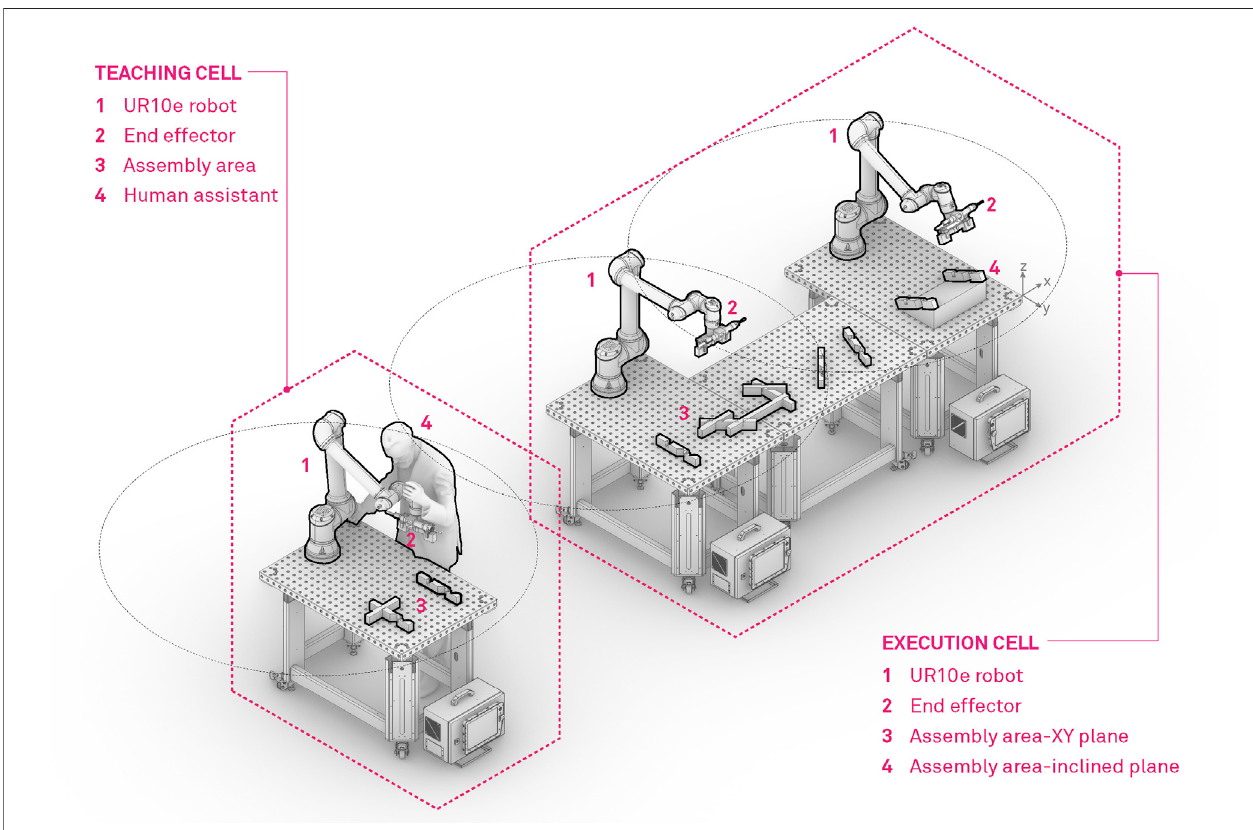
FIGURE4| Robotconceptcell,designedforfabricationoftimberstructures.Onthelefthandsideofthe fi gure,theteachingcellisrepresented,wheretheoperator teaches the robot actions with the help of LbD. The right hand side, represents the execution cell, where the thought actions with a combination of manipulation and robot screwing actions are deployed for robotic assembly of timber structures.